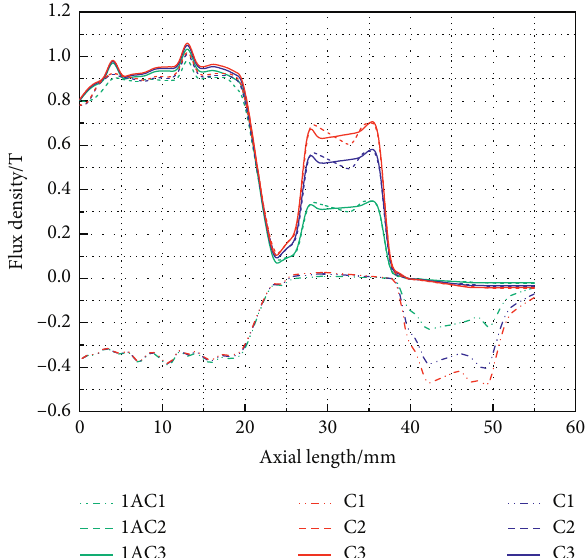
Figure 17: Axial distribution of flux density with excitation current.